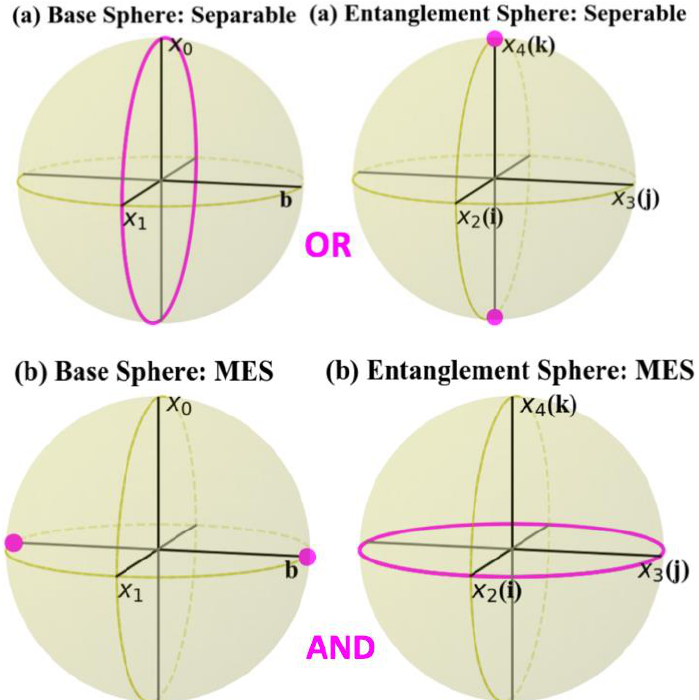
Figure 2. Two-qubit Bloch spheres, showing the base and entanglement spheres of the S 4 Hopf base for ( a ) the separable states and ( b ) the maximally entangled states (MES). For ( a ), the coordinates of either sphere means that the bipartite state is separable, and for ( b ), both sphere conditions must be satisfied for MES.